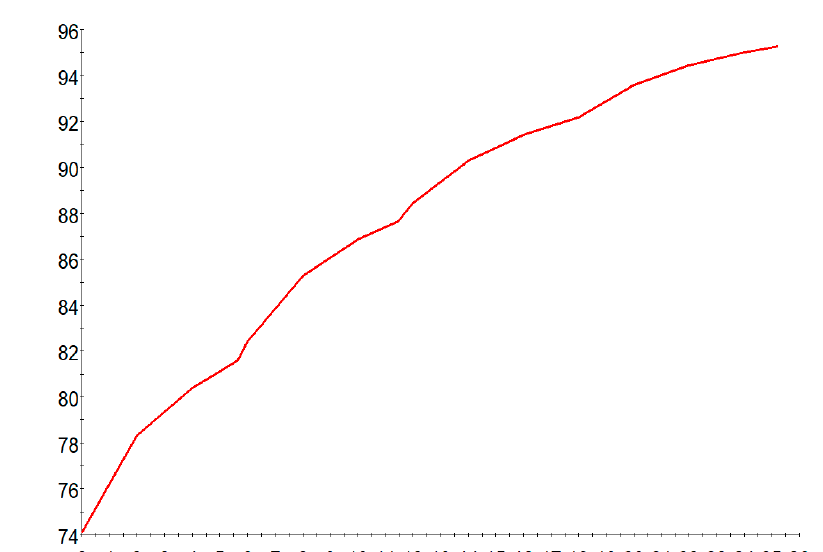
Figure 9. RON along the reactor height.